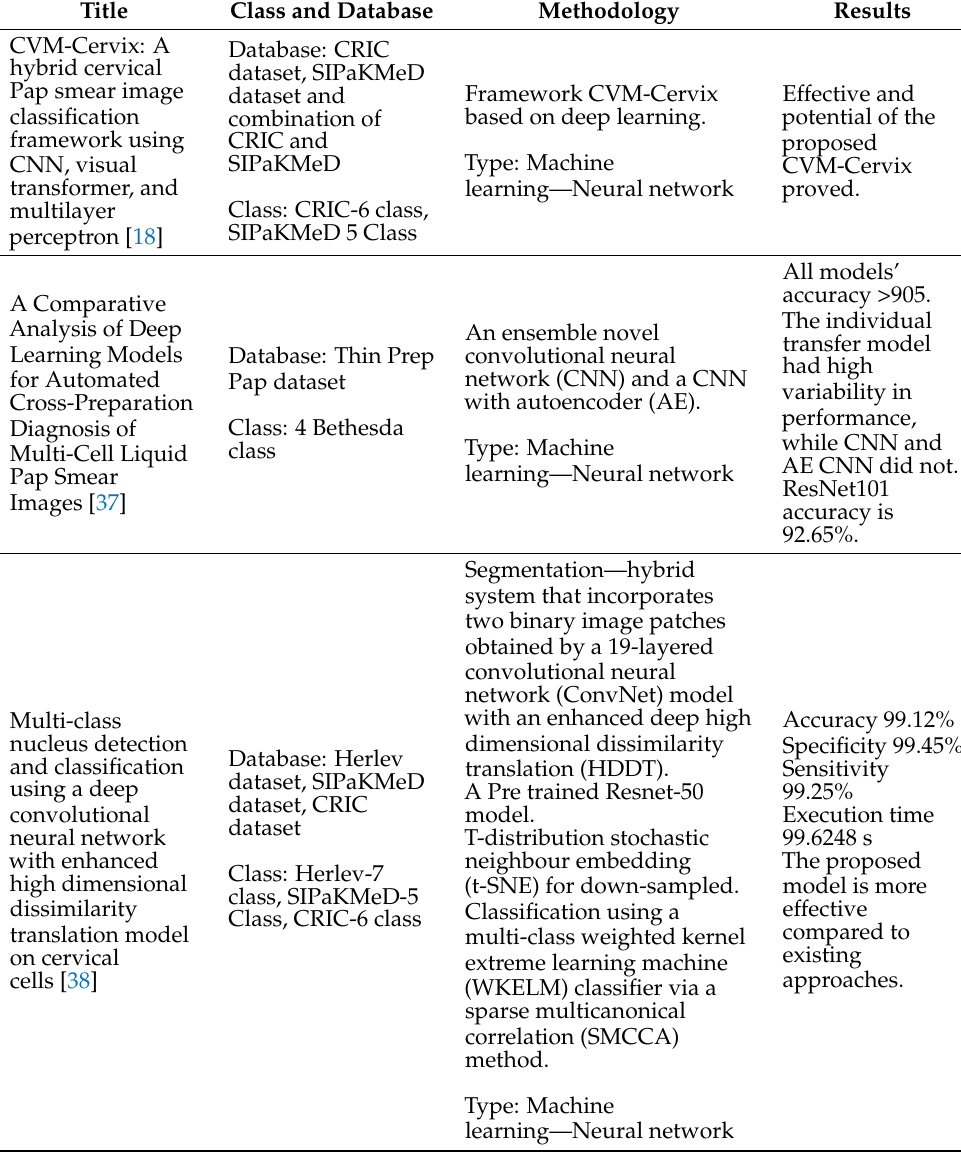
Table 3. Summary of the prevailing